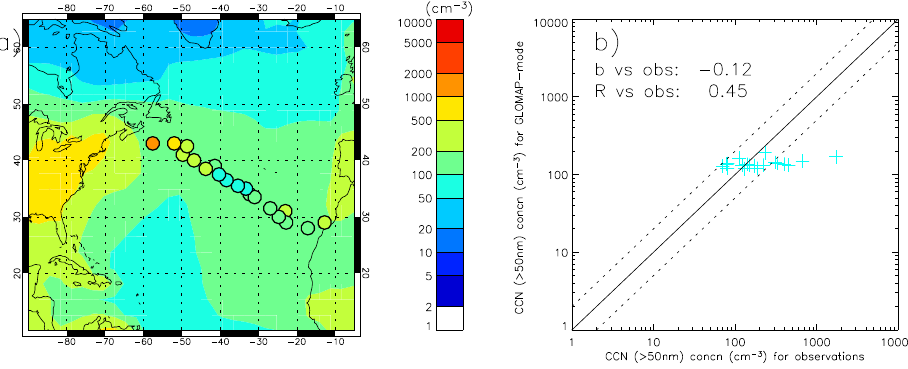
Fig. 25. Simulated marine CCN concentrations (particles larger than 50nm) over the North Atlantic compared to ship-borne observations from Van Dingenen et al. (1995). Values of b and R are shown comparing the observations with interpolated values from the model mean over September and